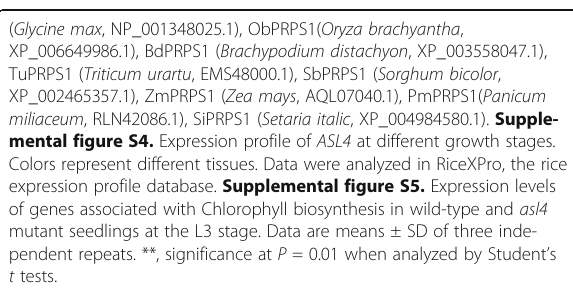
Colors represent different tissues. Data were analyzed in RiceXPro, the rice expression profile database. Supplemental figure S5. Expression levels of genes associated with Chlorophyll biosynthesis in wild-type and asl4 mutant seedlings at the L3 stage. Data are means ± SD of three inde- pendent repeats. **, significance at P = 0.01 when analyzed by Student ’ s t